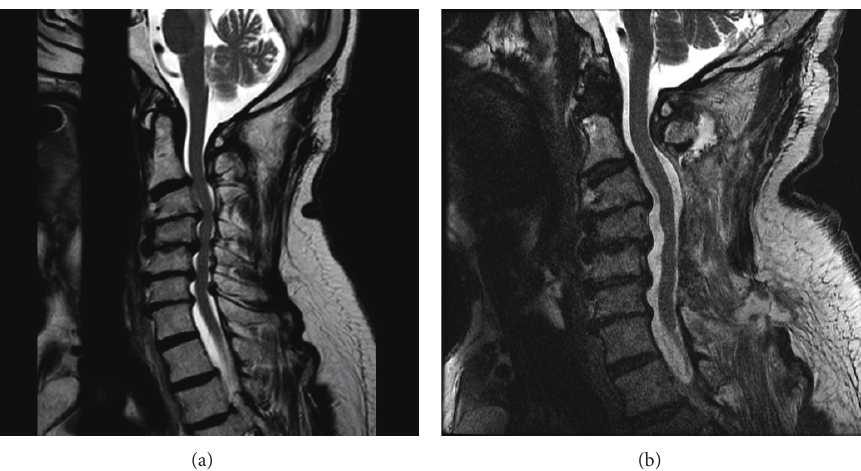
Figure 1: Pre- and postoperative T2-weighted sagittal MRI (static). Postoperative imaging in the neutral position appears to show satisfactory